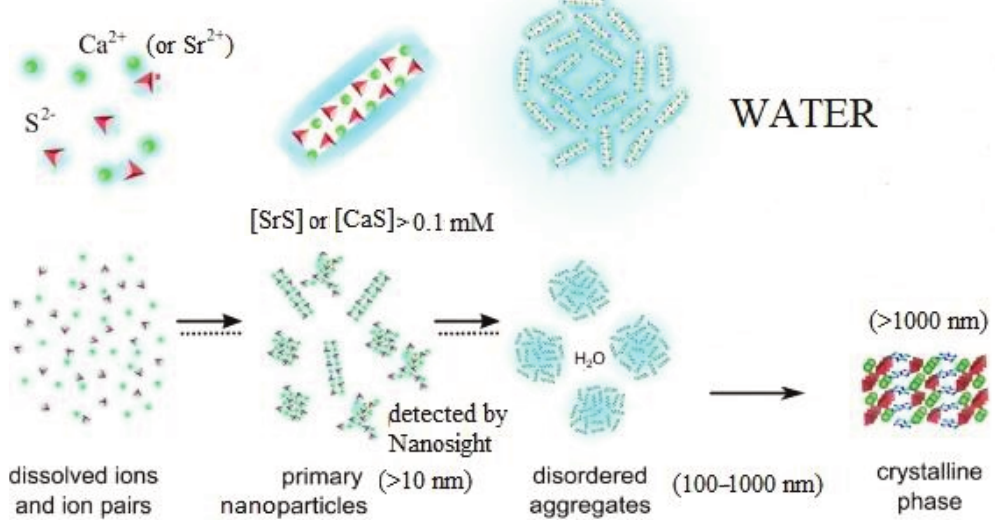
Fig. 3. Relation between the dissolved [SrS] (s) or [CaS] (s) and the size of the formed particles in aqueous media.